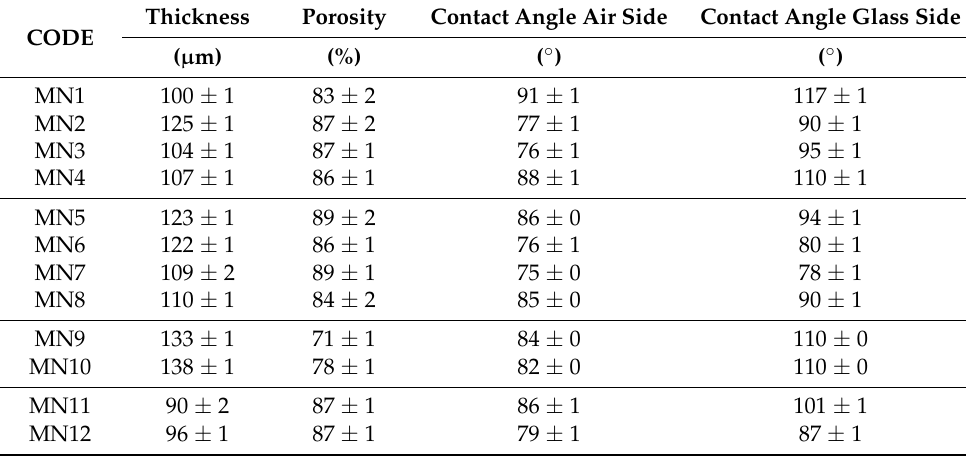
Table 4. Thickness, porosity and contact angle results of the investigated